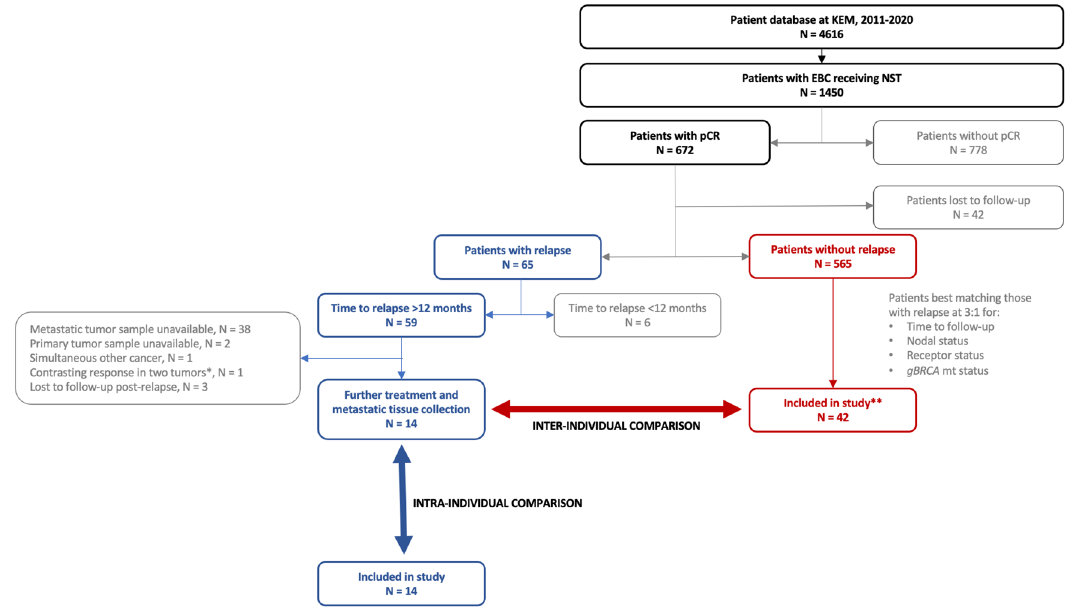
Fig. 1 Flowchart identifying patient and control selection. *Two primaries in the same breast, one relapsed while the other showed continued pCR. **A total of 42 controls were identi fi ed but immunohistochemical analysis failed in one control. Abbreviations: EBC early breast cancer, KEM Kliniken Essen-Mitte, NST neoadjuvant systemic therapy, pCR pathologic complete